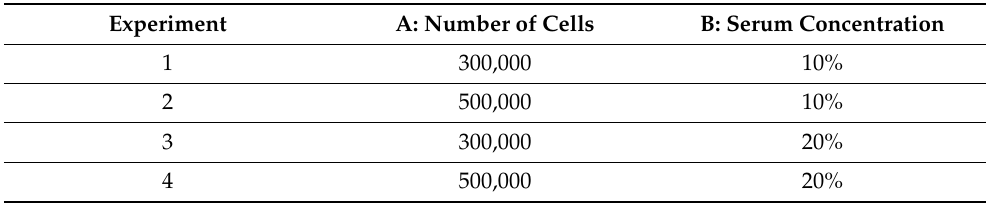
Table 2. Factors (A, B) and levels of the 2 2 factorial